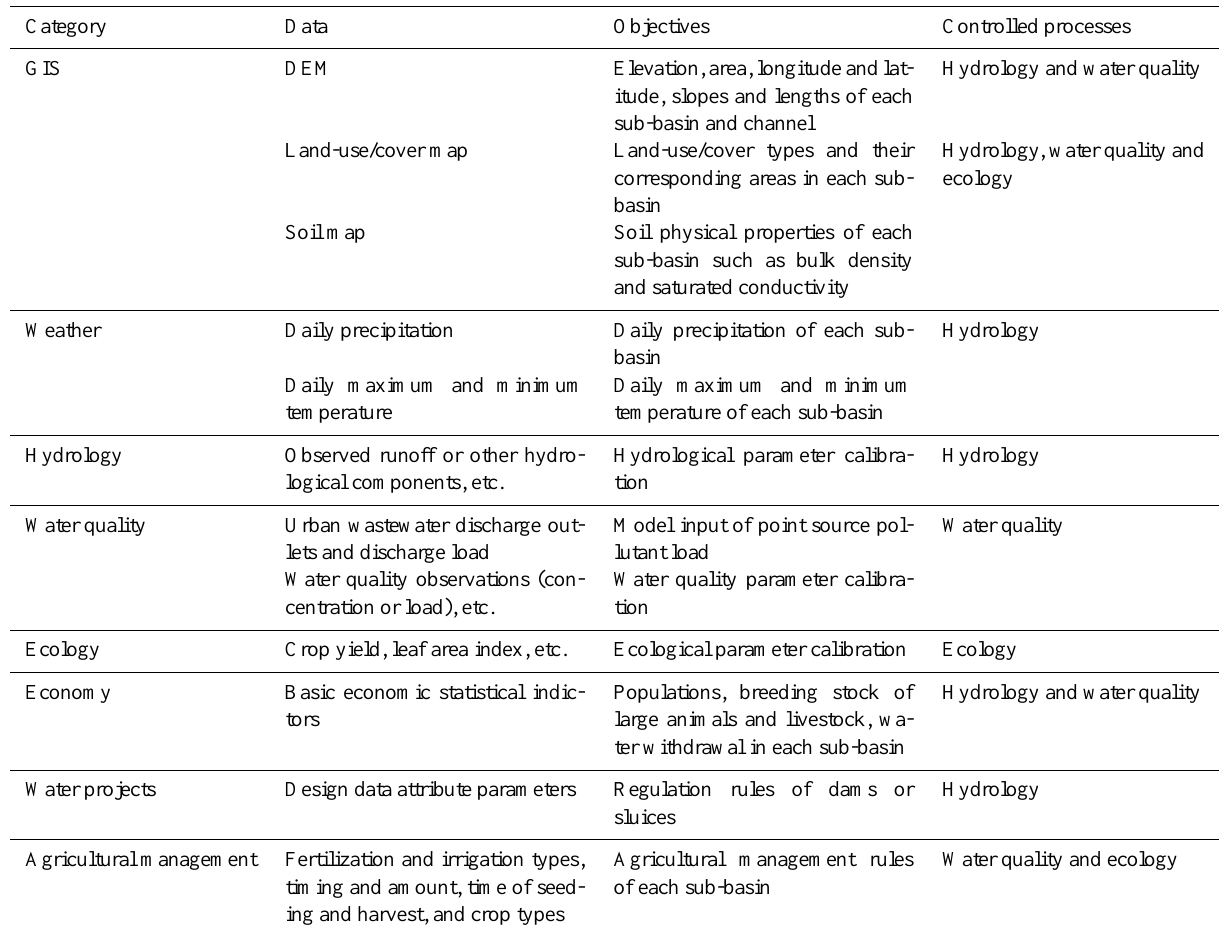
Table 1. The data sets and their categories used in the model.